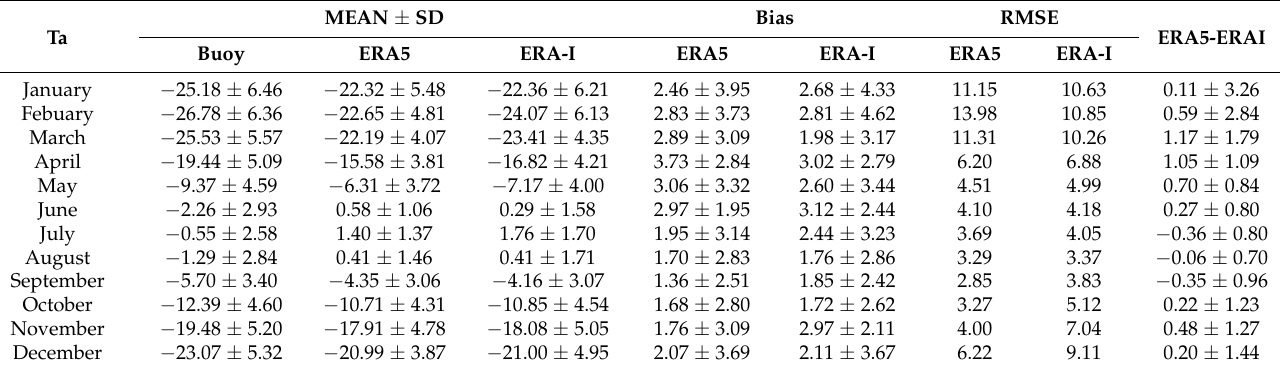
Figure 4. Rose diagram of the monthly biases of the Ta between the reanalysis datasets and the buoy observations based on the multi-year mean. Table 3. Monthly statistics of the mean biases and RMSE for Ta (°C).